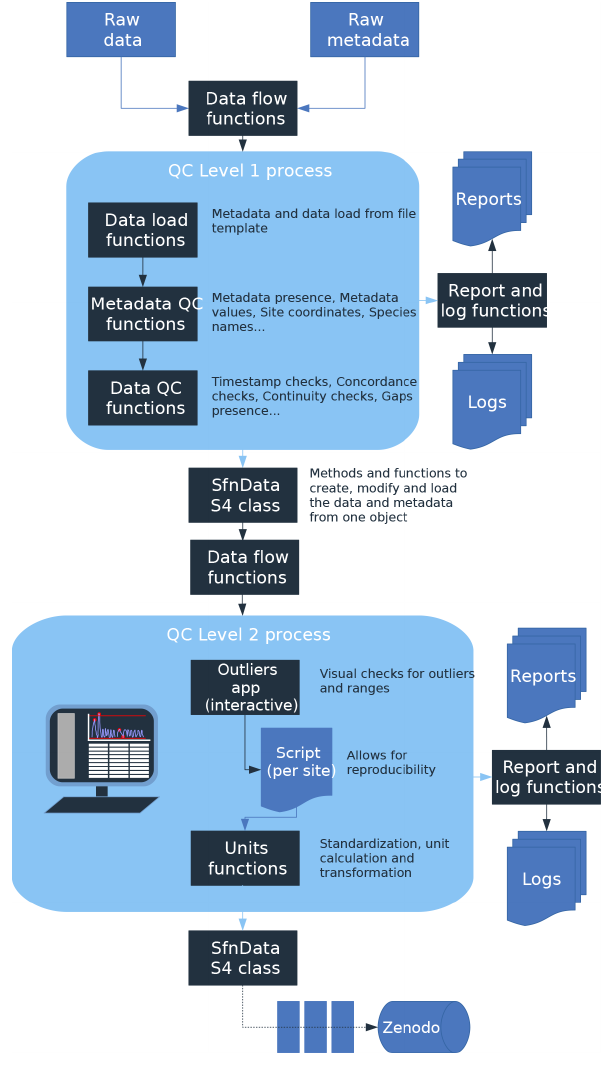
Figure 1. Overview of the SAPFLUXNET data workflow.